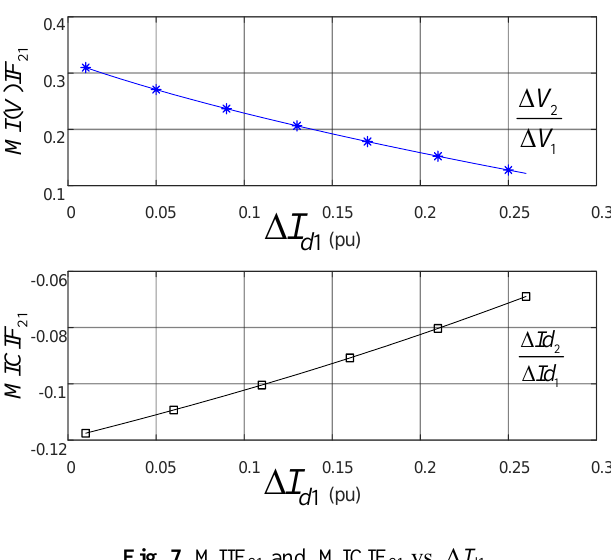
Fig. 7. MIIF 21 and MICIF 21 vs Δ I d1